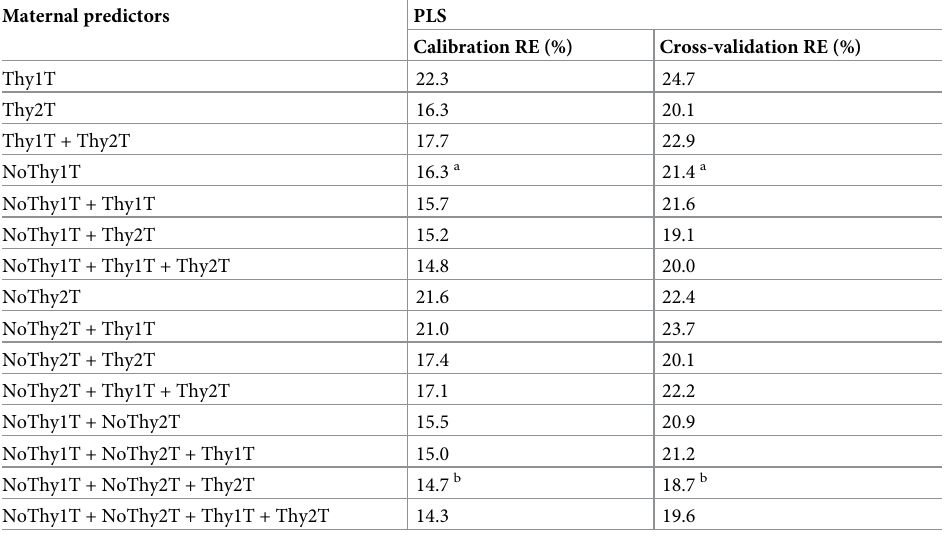
Table 3. Relative error of machine learning models that predict post load glycemia based on different maternal variables. Maternal predictors PLS Calibration RE (%) Cross-validation RE (%) Thy1T 22.3 24.7 Thy2T 16.3 20.1 Thy1T + Thy2T 17.7 22.9 NoThy1T 16.3 a 21.4 a NoThy1T + Thy1T 15.7 21.6 NoThy1T + Thy2T 15.2 19.1 NoThy1T + Thy1T + Thy2T 14.8 20.0 NoThy2T 21.6 22.4 NoThy2T + Thy1T 21.0 23.7 NoThy2T + Thy2T 17.4 20.1 NoThy2T + Thy1T + Thy2T 17.1 22.2 NoThy1T + NoThy2T 15.5 20.9 NoThy1T + NoThy2T + Thy1T 15.0 21.2 NoThy1T + NoThy2T + Thy2T 14.7 b 18.7 b NoThy1T + NoThy2T + Thy1T + Thy2T 14.3 19.6 a Model with the lowest RE for post load glycemia prediction, using 1T data only. b Model with the lowest RE for post load glycemia prediction, including 2T